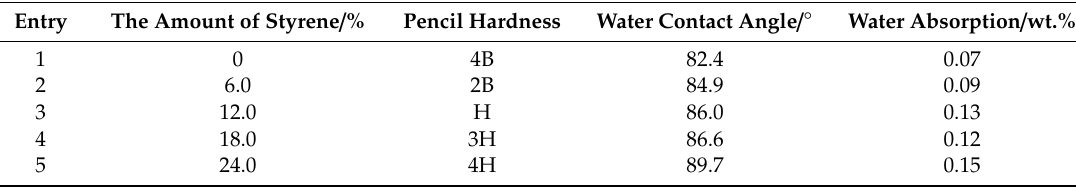
Table 2. E ff ect of styrene amounts on the Table 2. Effect of styrene amounts on the coatings.